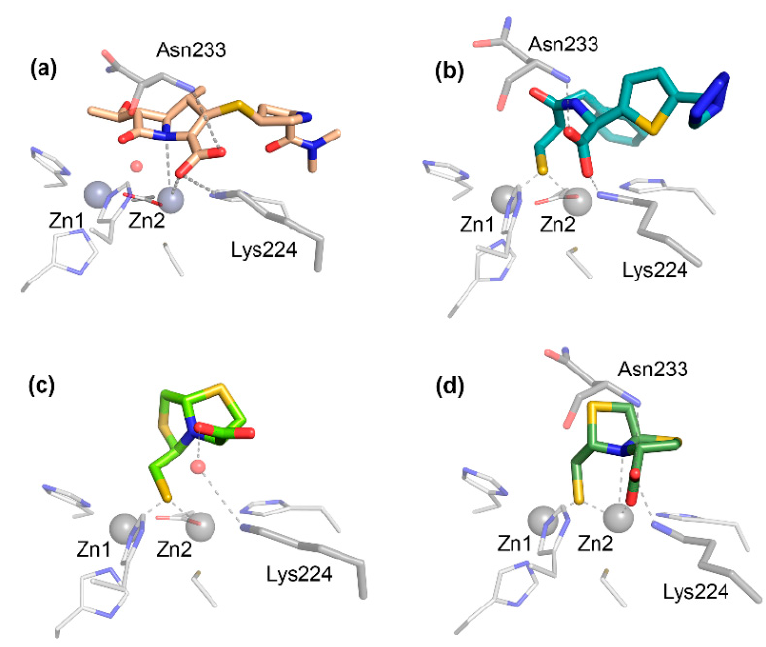
Figure 4. Binding modes of substrate mimic inhibitors. ( a ) Modeled structure of meropenem bound to NDM-1; crystal complexes of ( b ) mercaptocarboxylate 1 :IMP-1 (PDB 1dd6) [148], ( c ) L-CS319 L- 6 :NDM-1 (PDB 4u4l) [149], and ( d ) D-CS319 D- 6 :IMP-1 (PDB 5ev8) [150]. Hydrogen bonds and metal ligands interactions are drawn with dashed lines.